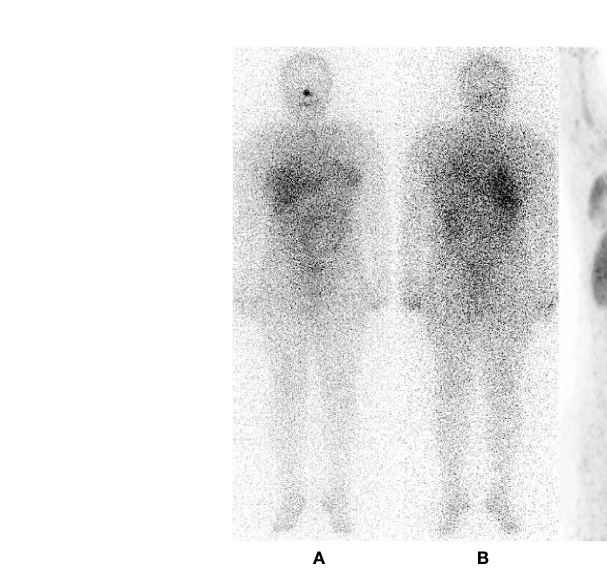
FIGURE 6 | 73 years old female treated with total thyroidectorny + RAI (cumulative dose 14800 MBq); Thyroglobulin 546 ng/ml. (A, B) 121 I – post therapy whole body scan shows no uptake other than usual biodistribution. Physiological uptake variant was observed in mamary glands with both tracers. (C) 68 Ga – PSMA PET/ CT MIP, on the other hand, conspicuously shows a central cervical compartment adenopathy.